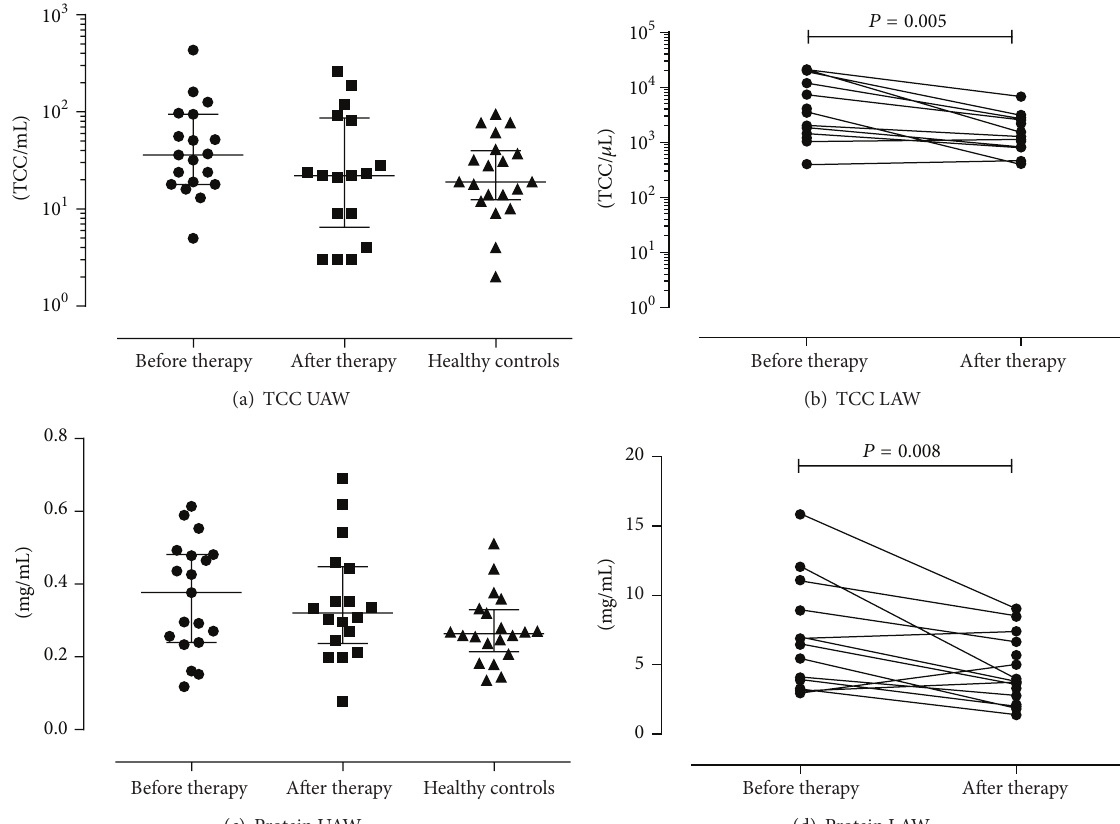
Figure 2: Changes of TCC and protein concentration. Both decreased in UAW and LAW after IV-antibiotic therapy, but only the decline in the LAW was shown to be statistically significant for TCC (b) and protein (d). Similar results were seen for CF patients’ UAW and healthy controls (a +